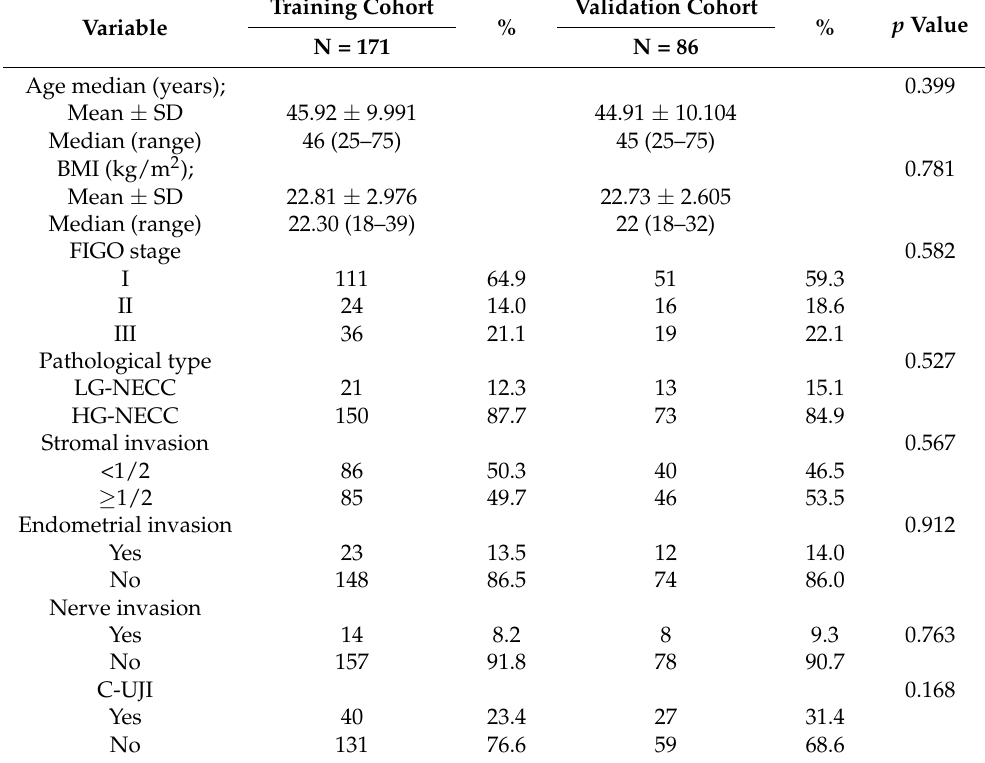
Table 1. The clinicopathological characteristics of the training group and validation